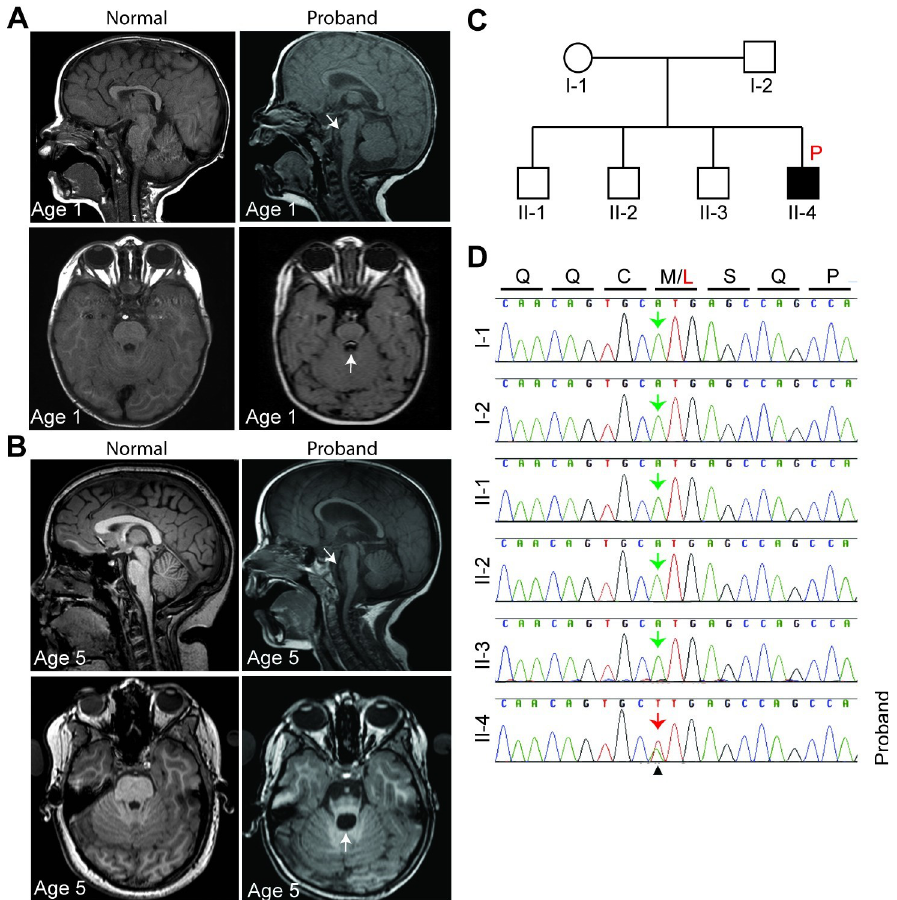
Fig 1. De novo FOXR1 missense variant in a proband with microcephaly and brain atrophy. (A) MRI scans of mid- sagittal (top) and horizontal (bottom) view of normal age-matched and the proband at 1 year old. (B) MRI scans of mid-sagittal (top) and horizontal (bottom) view of normal age-matched and the proband at 5 years old. Arrow on mid- sagittal images indicate hypoplasia of the pons in the proband. Also, arrow on horizontal view show dilation of ventricle in the proband compared to age-matched normal individual. (C) Pedigree of the family where the letter P in red (black square) indicates the proband. (D) Sanger sequence analysis confirming the de novo FOXR1 variant. Sequence chromatograms demonstrate the presence of the heterozygous variant in the proband, II-4 (indicated by the red arrow) and the reference allele in both parents and siblings (green arrows). Letters on top indicate amino acid residues (Q = glutamine, C = cysteine, M = methionine, L = leucine, S = serine, P =